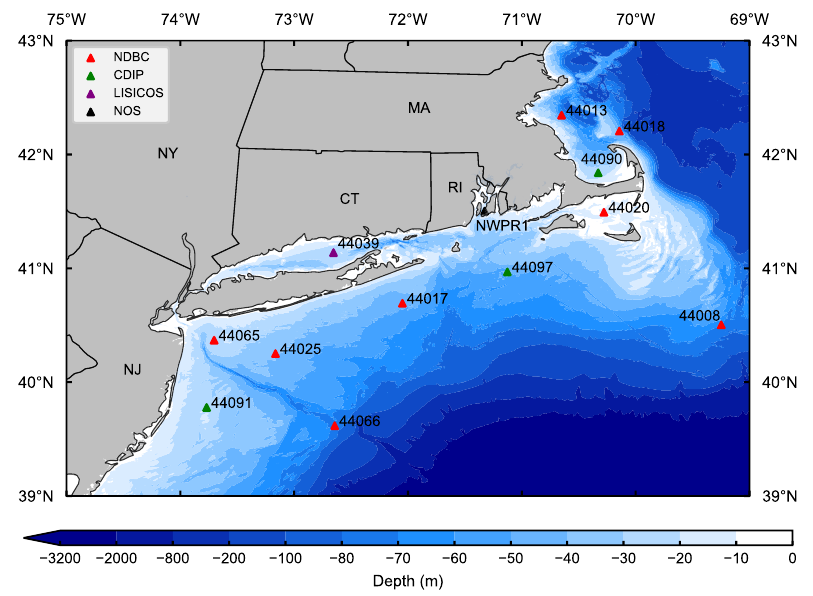
Figure 1. Map of the buoy and NWPR1 (Newport, RI, USA) stations along with the bathymetry of the